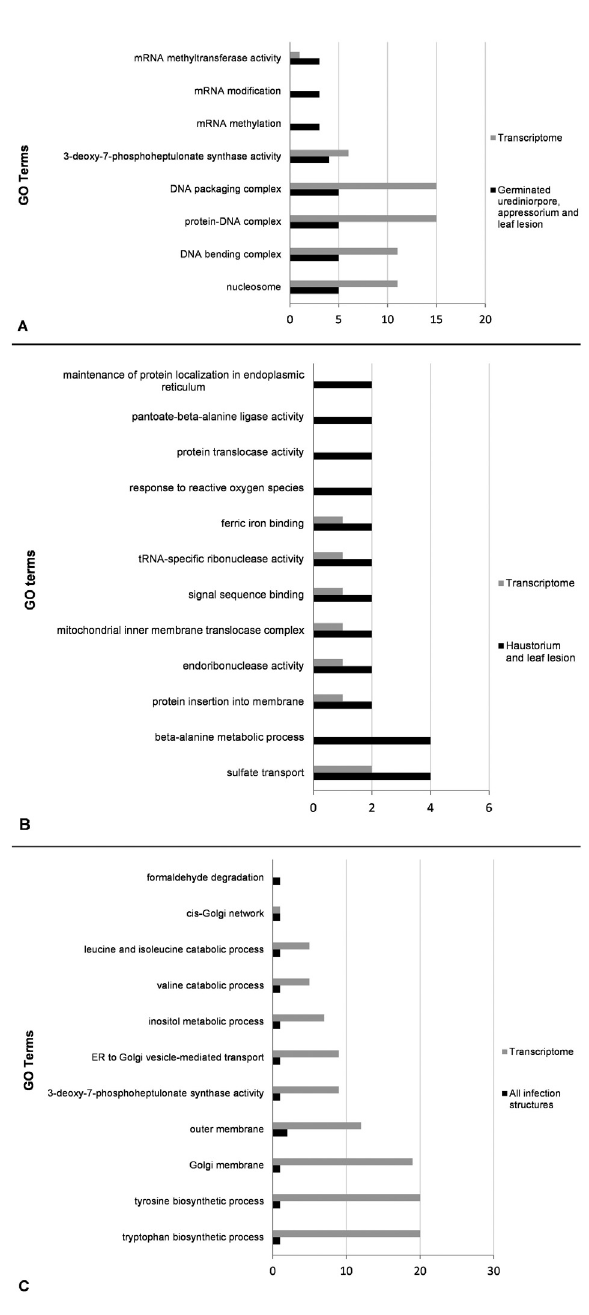
Figure 4 - Differential gene ontology (GO) term distribution between the P. pachyrhizi transcriptome (36,350 contigs) and fungal infection struc- tures. (A) Transcripts common to germinated urediniospores, appressoria, and leaf lesions (423 contigs); (B) transcripts common to haustoria and leaf lesions (3,265 contigs); (C) transcripts common to all infection struc- tures, germinated urediniospores, appressoria, haustoria, and leaf lesions (48 contigs). Graph B shows only the molecular classes enriched for tran- scriptscommontohaustoriaandleaflesions.Thegraphwasautomatically generated after the enrichment analysis using the BLAST2GO tool (Fisher’s exact test, FDR adjusted p -value <